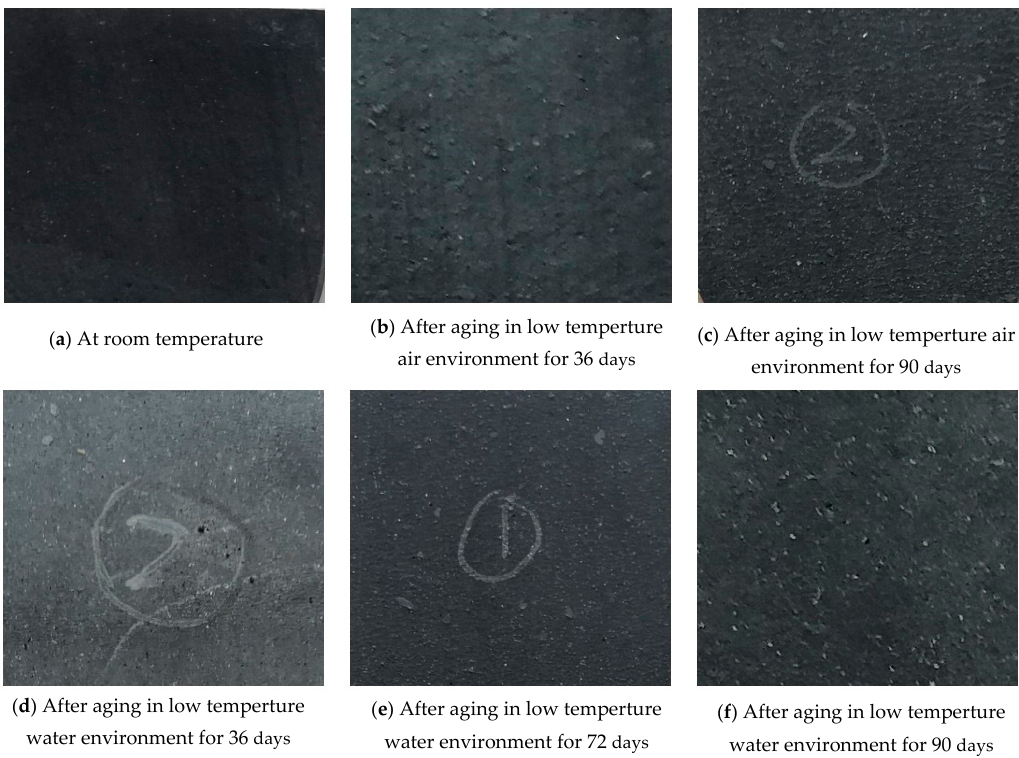
Figure 6. Apparent morphology of the specimen after aging at low temperature.